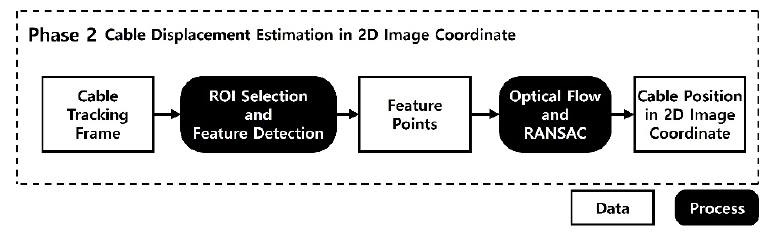
Figure 4. Overview of cable tracking in the image coordinate.